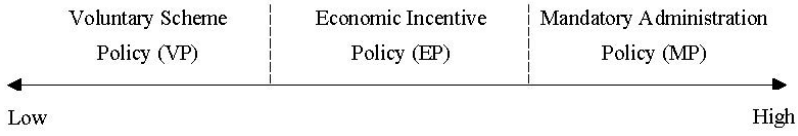
Figure 2. The degree of policy enforcement by government.